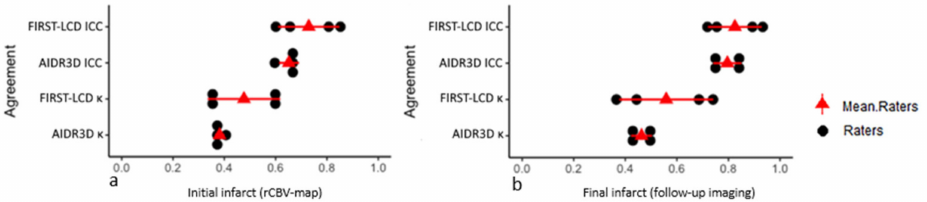
Figure 3. Dotplot showing comparative agreements between AIDR3D and FIRST-LCD according to rCBV-map ( a ) and follow-up imaging ( b ). Means raters agreements were computed for visual